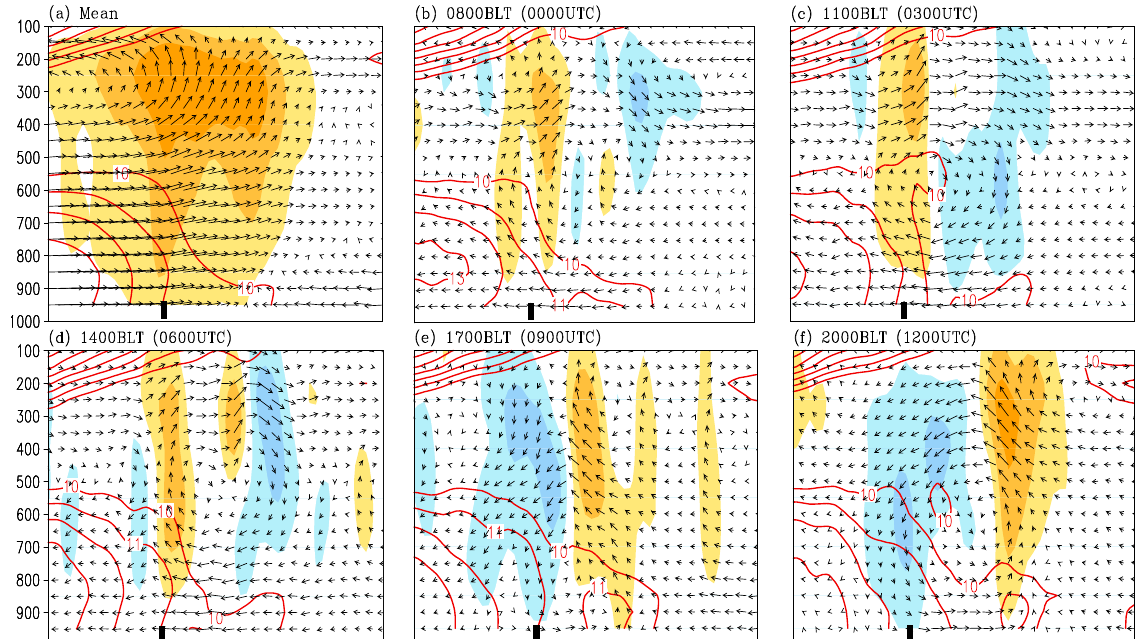
Figure 10. Exp CTL simulation of mean vertical velocity (shaded, unit: 10 –2 m·s –1 ) and height-latitudinal circulation ( v , w ) ( a ) and the diurnal evolution of anomalous vertical velocity (shaded, unit: 10 –2 m·s –1 ) and height-latitudinal circulation ( v , w ) averaged over 112–114°E for the 10-day period at ( b ) 0800 BLT, ( c ) 1100 BLT, ( d ) 1400 BLT, ( e ) 1700 BLT, ( f ) 2000 BLT, ( g ) 2300 BLT, ( h ) 0200 BLT and ( i ) 0500 BLT. Units v and w are in m·s –1 ; w is multiplied by 20. The contour interval is one, and only those horizontal winds greater than 10 m·s –1 are shown. The black bar roughly demonstrates the land-sea